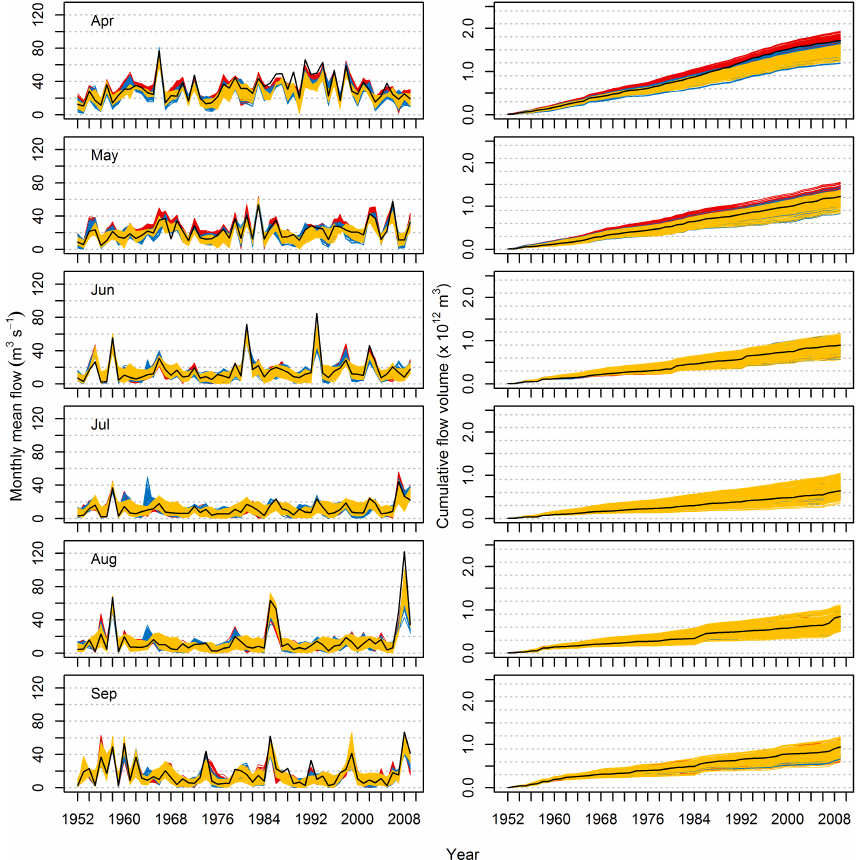
Figure 6. Monthly (left panels) mean and (right panels) cumulative volume of reconstructed and observed flow for 1952–2009 for the summer half-year (April to September). Colour code as in Fig.